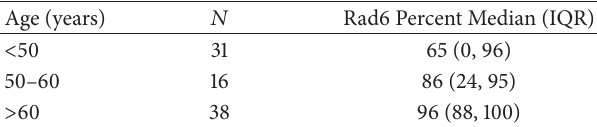
Table 2: Rad6 positive cells by age